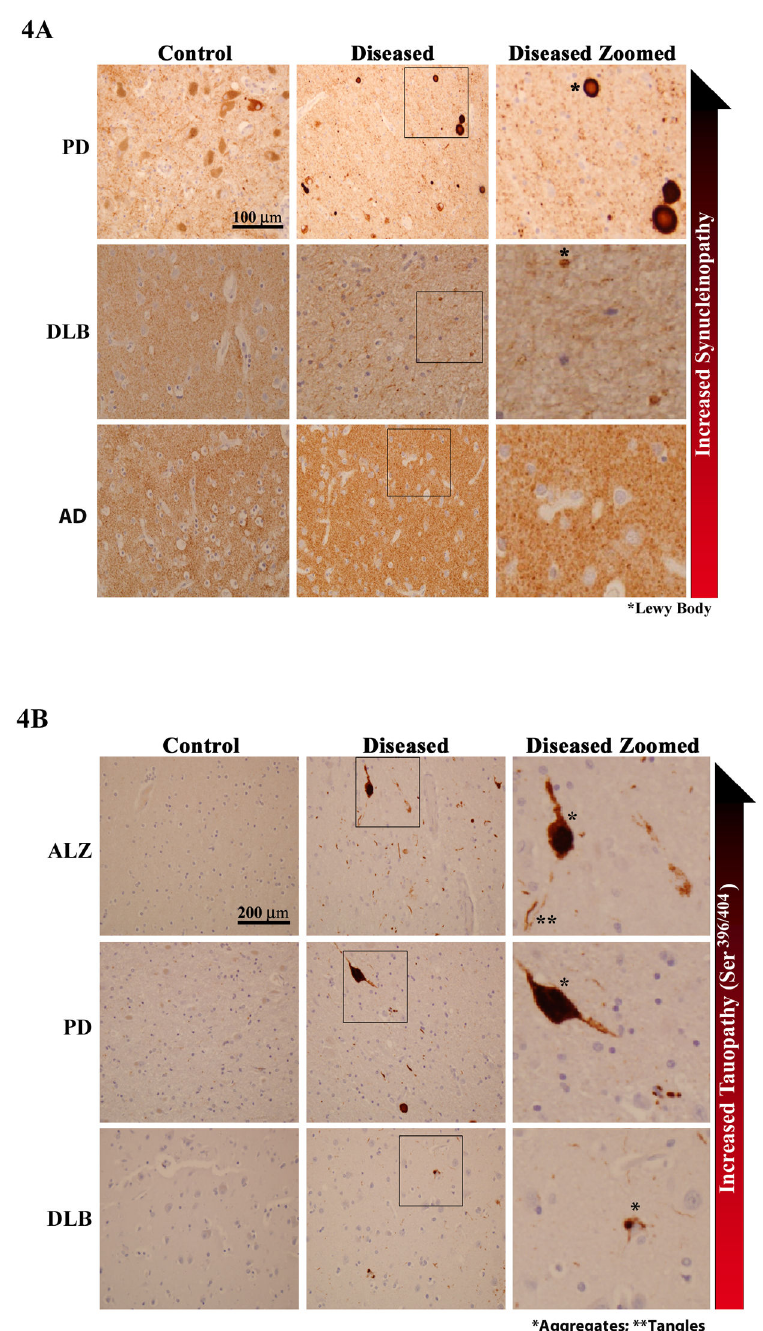
Figure 4. Immunohistochemical analyses of α-Syn and p-Tau. IHC of paraffin embedded tissue from AD FC, PD substantia nigra and DLB FC with appropriate aged matched non-diseased controls, were conducted as described in Methods of File S1. [A] Analysis of α-Syn associated pathology in PD [uppermost horizontal panel], DLB [middle horizontal panel] and AD [lower horizontal panel] comparing age matched control tissue [left vertical panel] with diseased tissue [middle and right-magnified vertical panels]. Lewy bodies increased in intensity and density as follows: PD > DLB > AZ. * denotes Lewy bodies and were present only in PD and DLB tissues. [B] Analysis of p-Ser396/404 associated pathology in AD [uppermost horizontal panel], PD substantia nigra [middle horizontal panel] and DLB [bottom horizontal panel], compared age matched control tissue [left vertical panel] with diseased tissue [middle and right-magnified]. * Aggregates, ** Tangles.